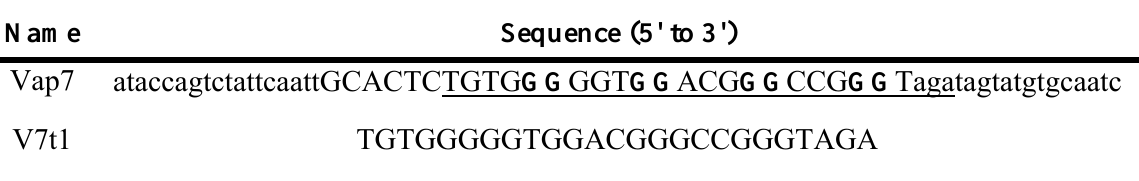
Table 2. The sequences of Vap7 and V7t1. The small letters in the sequence of Vap7 shows sub-sequences originating from the primers. Guanine bases that participate in the formation of the G-quadruplex structure are shown in bold face. The underlined sequence in the Vap7 sequence was also found in V7t1.